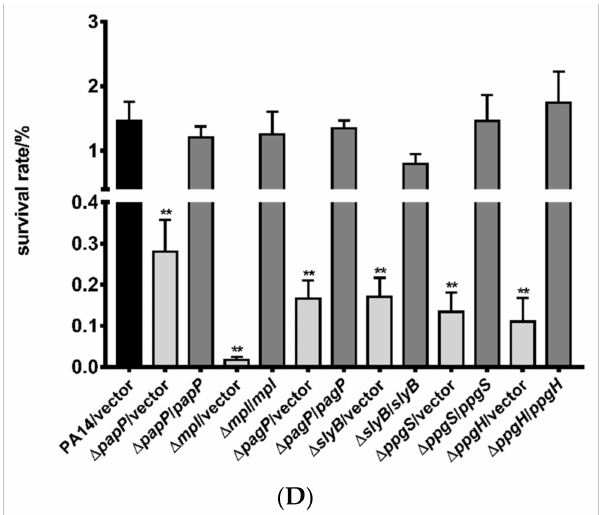
Figure 3. Roles of the PhoP regulated genes in the bacterial tolerance to polymyxin B and LL-37. Survival rates of the PA14 transposon insertion mutants ( A ), corresponding in-frame deletion mutants and respective complemented strains ( B ) after polymyxin B treatment. The strains were treated with polymyxin B (0. 78 µ g/mL) for 2.5 h at 37 ◦ C. Error bars represent standard errors. ns, not significant. **, p < 0.01, ***, p < 0.001, compared to wild-type PA14 by Student’s t test. ( C ) The indicated strains were grown in LB to an OD 600 of 1.0 and treated with 0.039 µ g/mL (0.125 MIC) or 0.078 µ g/mL (0.25 MIC) polymyxin B for 2.5 h. Then the bacterial cells were stained with 2 µ g/mL